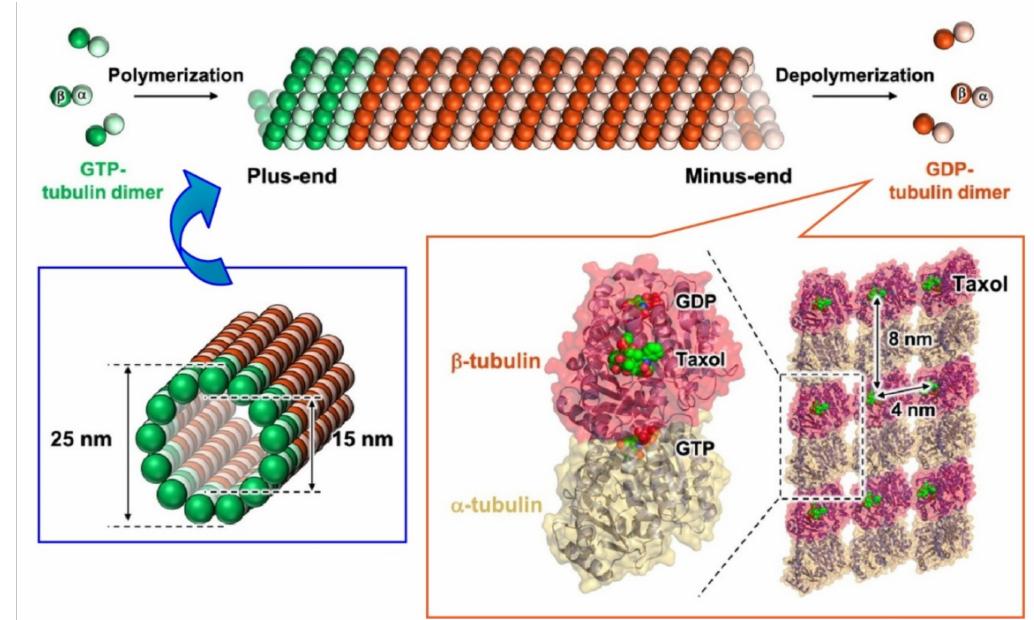
Figure 20. Microtubules are known as hollow cytoskeletons formed through the formation of linear protofilaments upon head-to-tail self-assembly of tubulin dimers, subsequent sheet structure formation, and finally closing of the formed sheets. Reprinted with permission from Reference